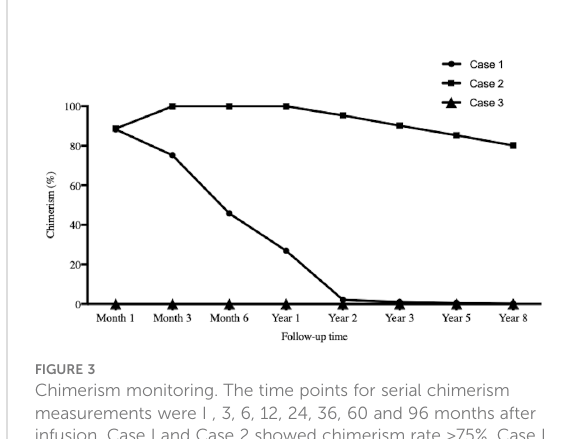
FIGURE 3 Chimerism monitoring. The time points for serial chimerism measurements were I , 3, 6, 12, 24, 36, 60 and 96 months after infusion. Case I and Case 2 showed chimerism rate >75%. Case I experienced gradual decrease in chimerism rate until maintaining micro-chimerism status from Month 24. Case 2 showed mixed chimerism in the early stage and met the standard of complete chimerism at Month 3. There was no chimerism status detected in Case